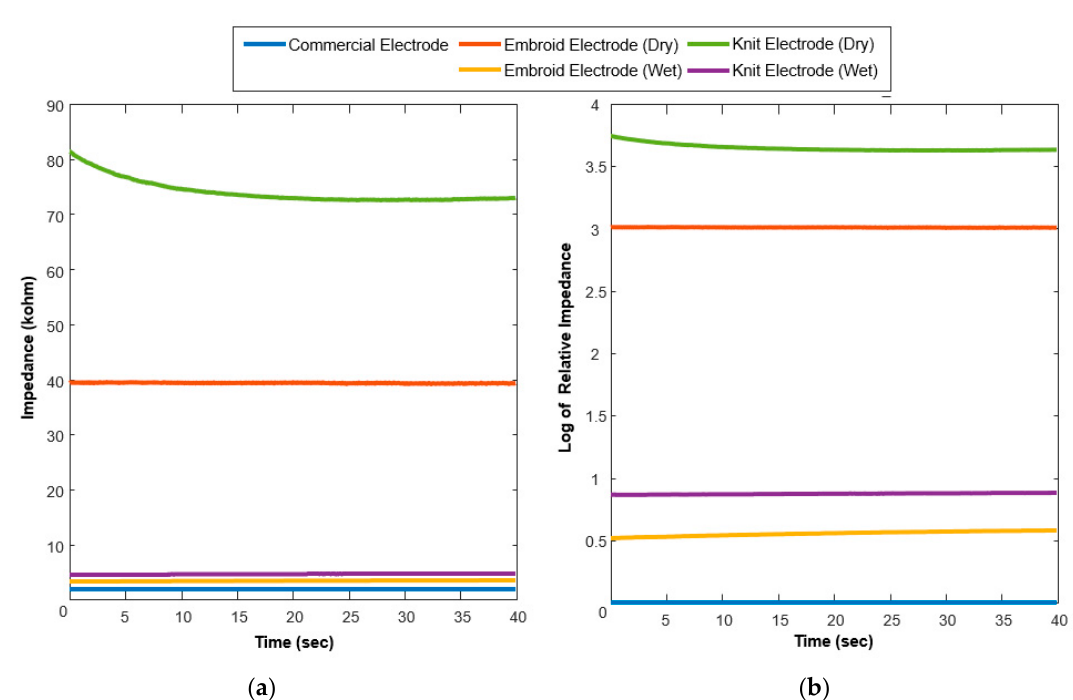
Figure 11. ( a ) Real-time impedance profiles of each electrode such as the commercial electrode, the proposed embroidered electrode in the dry and wet conditions, and the knitted electrode in the dry and wet conditions; ( b ) real-time impedance profiles of each electrode (embroidered electrode in the dry and wet conditions, and the knitted electrode in the dry and wet conditions) relative to the mean impedance of commercial electrode. Where the impedances were calculated after being sampled at 20 kHz frequency. Table 2. Classification accuracy of shoulder postures using the proposed convolutional neural network (CNN) networks